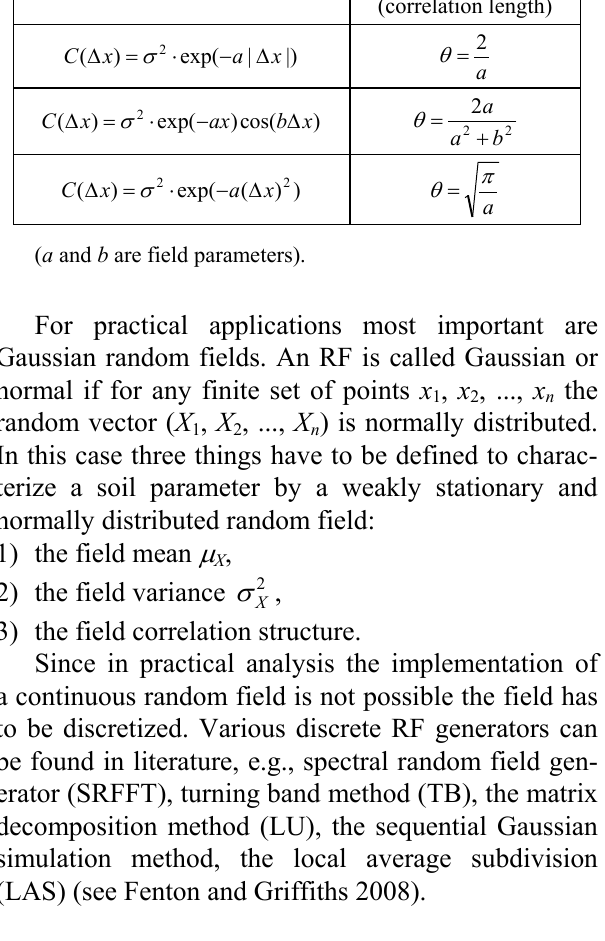
Scale of fluctuation (correlation